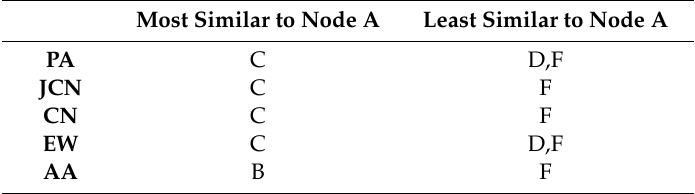
Table 2. Most and least similar nodes for node A determined by neighbor-based